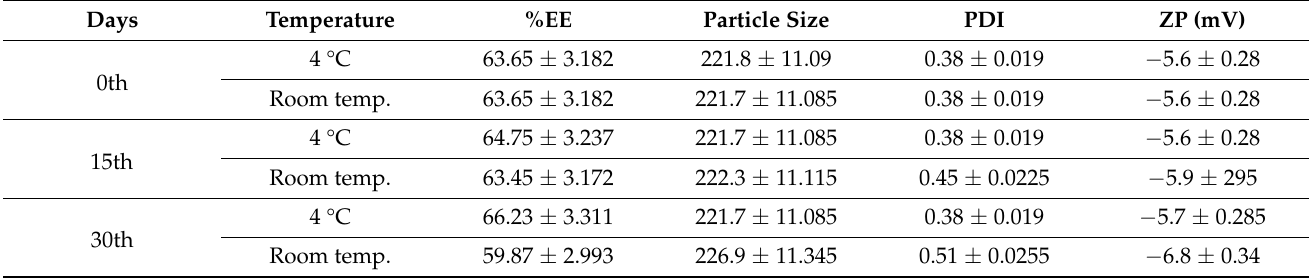
Table 3 . Stability study of CEO-NE formulations. Table 3. Stability study of CEO-NE